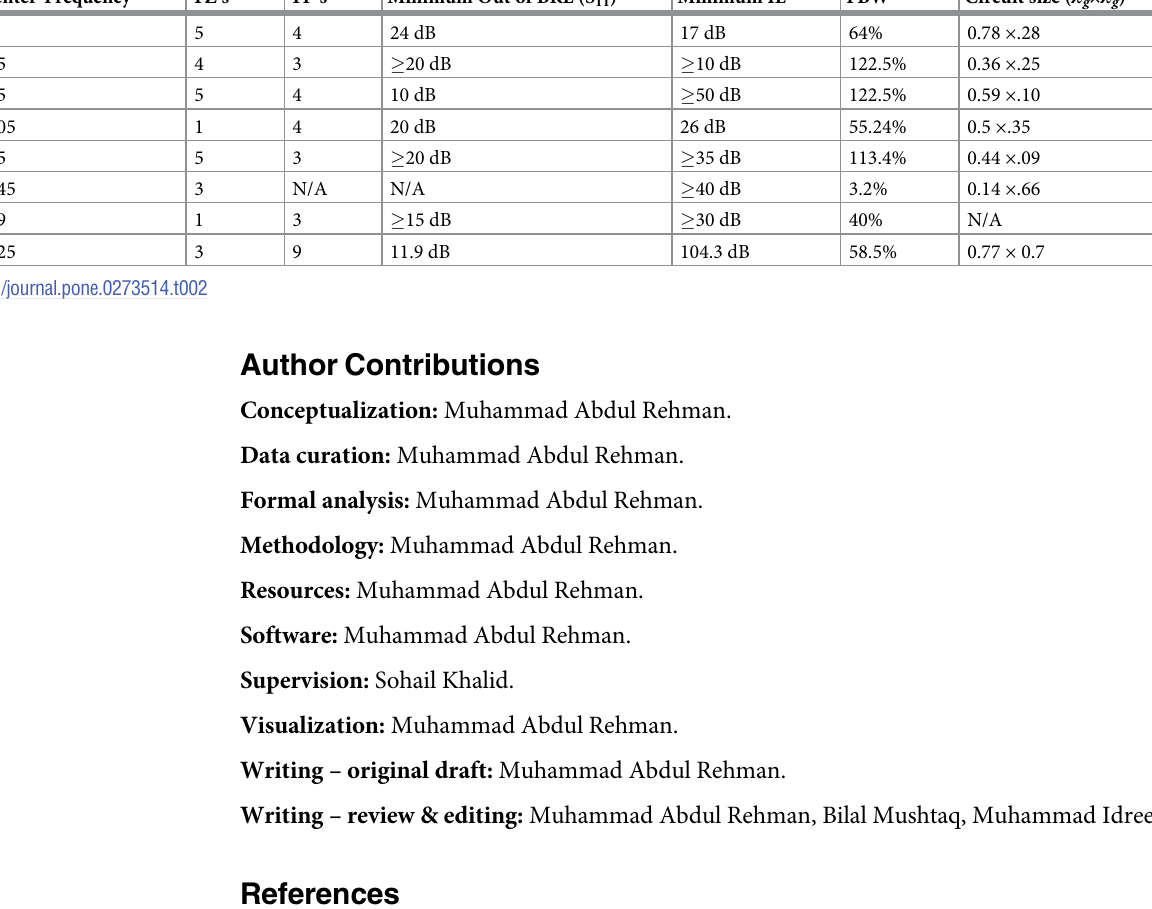
Table 2. Comparison between previous studies and proposed work.